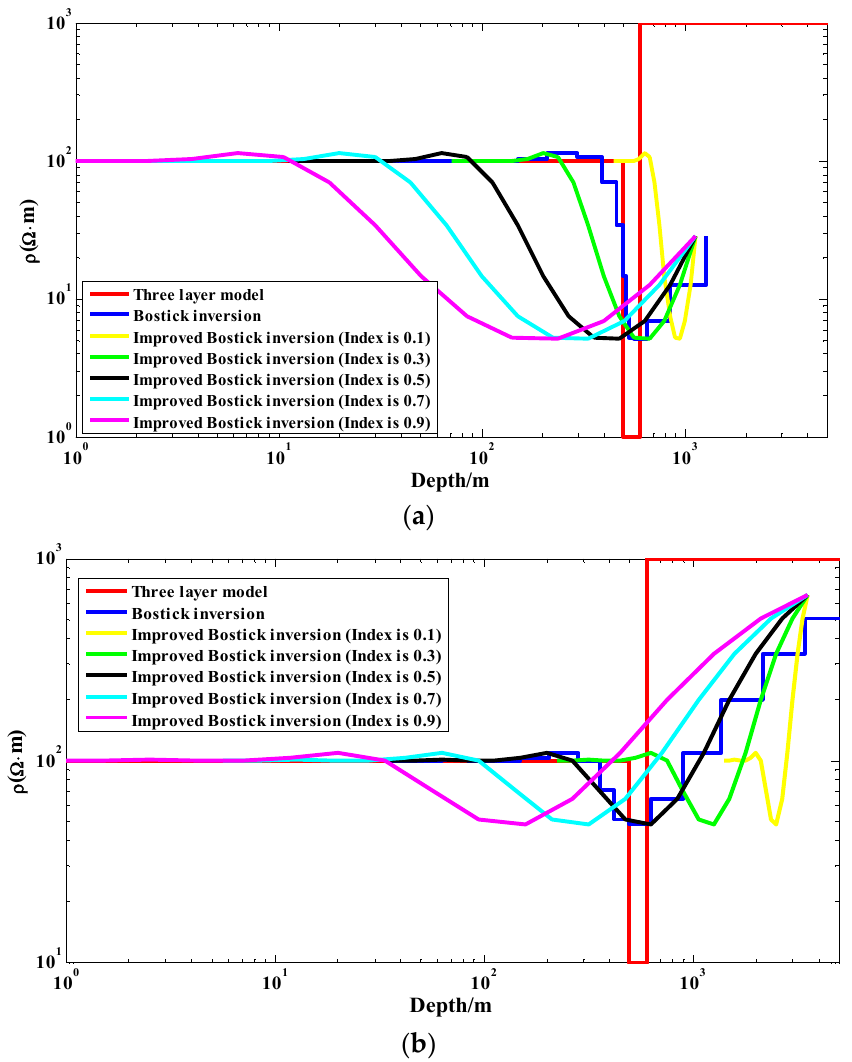
Figure 3. Comparison of the Bostick inversion and the improved Bostick inversion based on the direct depth transformation formula. ( a ) The middle target layer of the model is 1 Ω ·m; ( b ) The middle target layer of the model is 10 Ω ·m. Each curve in the figure represents the Bostick inversion results when the frequency parameter in the direct depth transformation formula has different values.